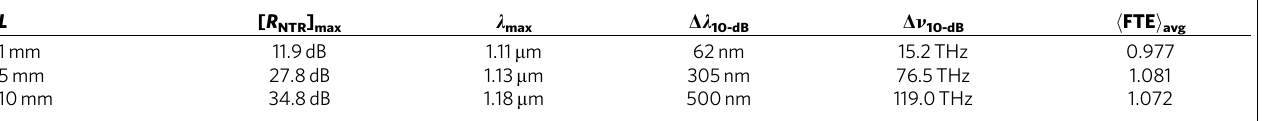
The listed parameters are peak nonreciprocal transmission ratio (NTR) [ R NTR ] max , peak NTR wavelength l max , 10dB NTR bandwidth D l 10dB and D n 10dB and average forward transmission efficiency h FTE i avg over the 10dB NTR